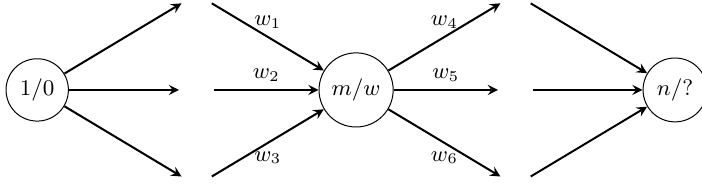
Figure 1: Minimum incoming weight label method applied to a typical node m